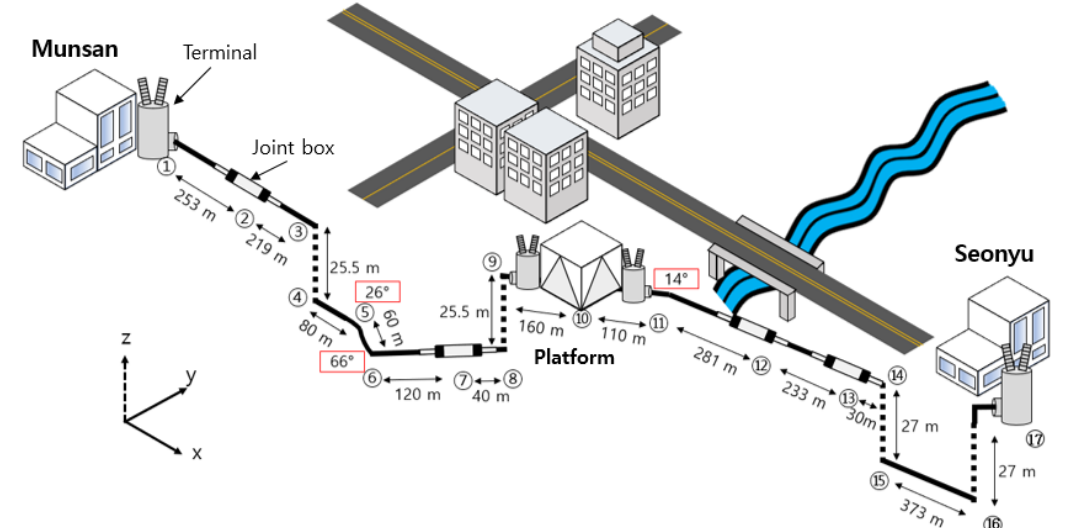
Figure 2. Layout of triaxial HTS power cable between Munsan and Seonyu substations.